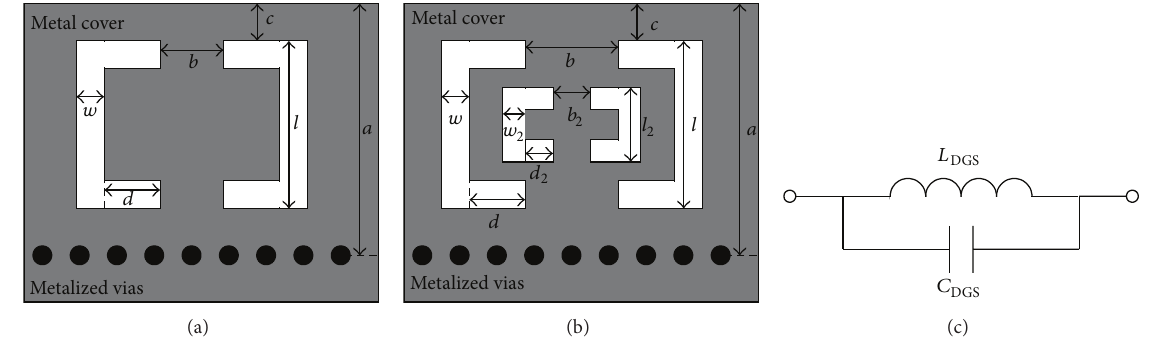
Figure 1: Proposed HMSIW-DGS cell, its embedded form, and equivalent circuit. (a) Proposed cell, (b) embedded form, and (c) equivalent circuit.